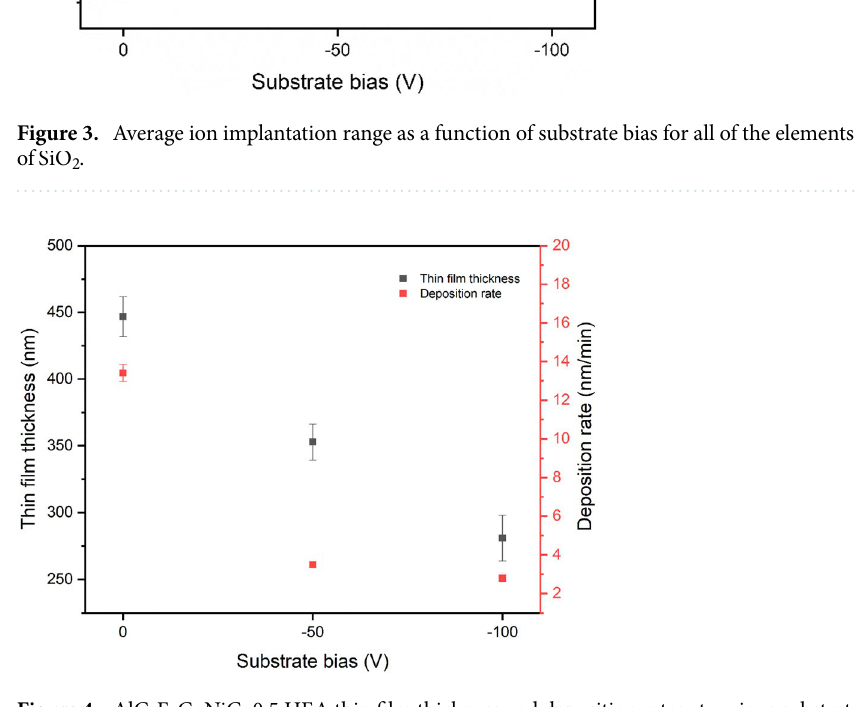
Figure 4. AlCrFeCoNiCu0.5 HEA thin film thickness and deposition rates at various substrate